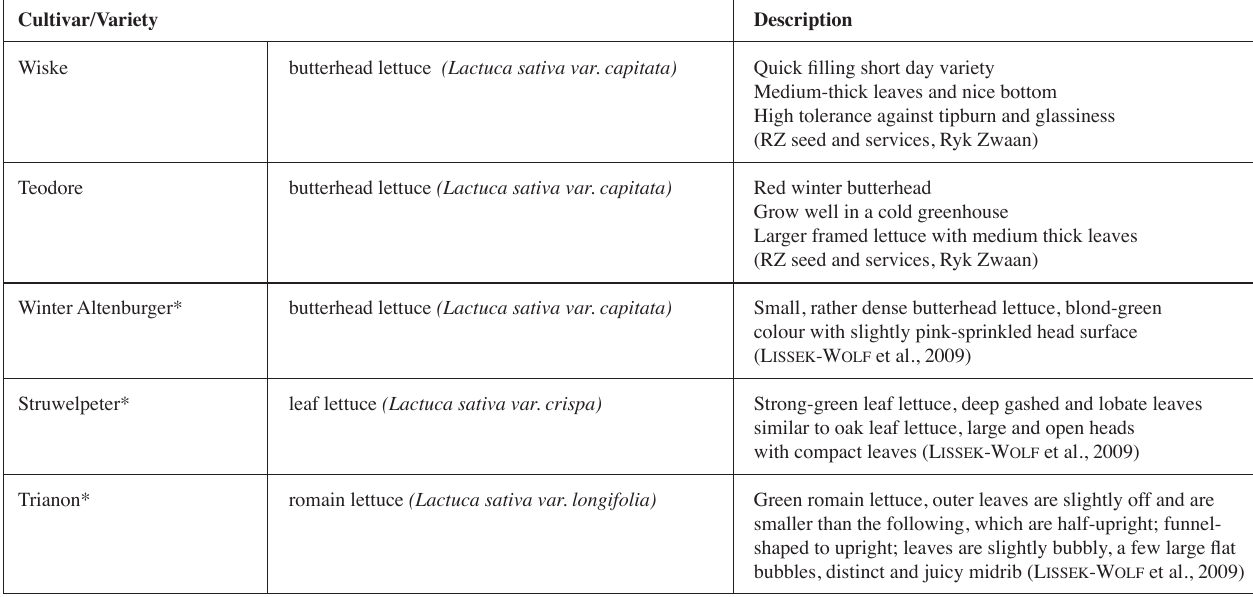
Tab. 1: Description of the studied lettuce cultivars and varieties